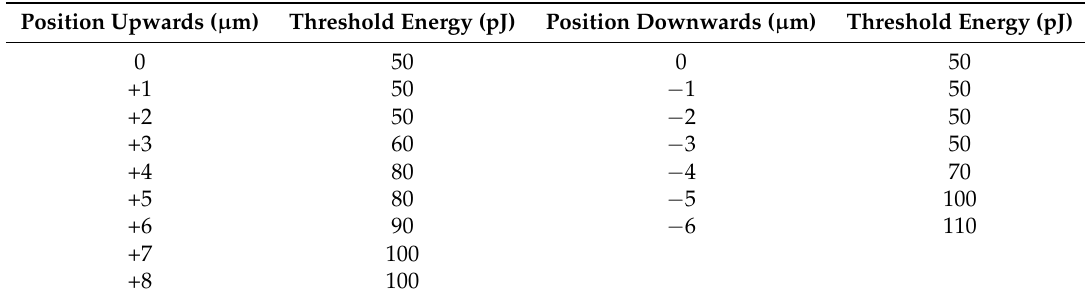
Table 4. Laser threshold energy distribution along Z axis.